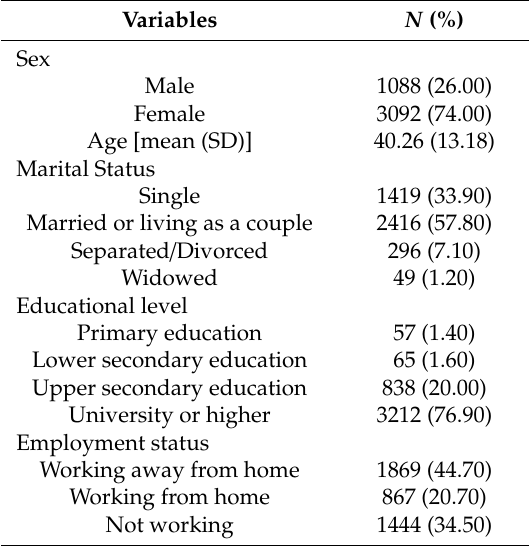
Table 1. Sociodemographic characteristics ( n =